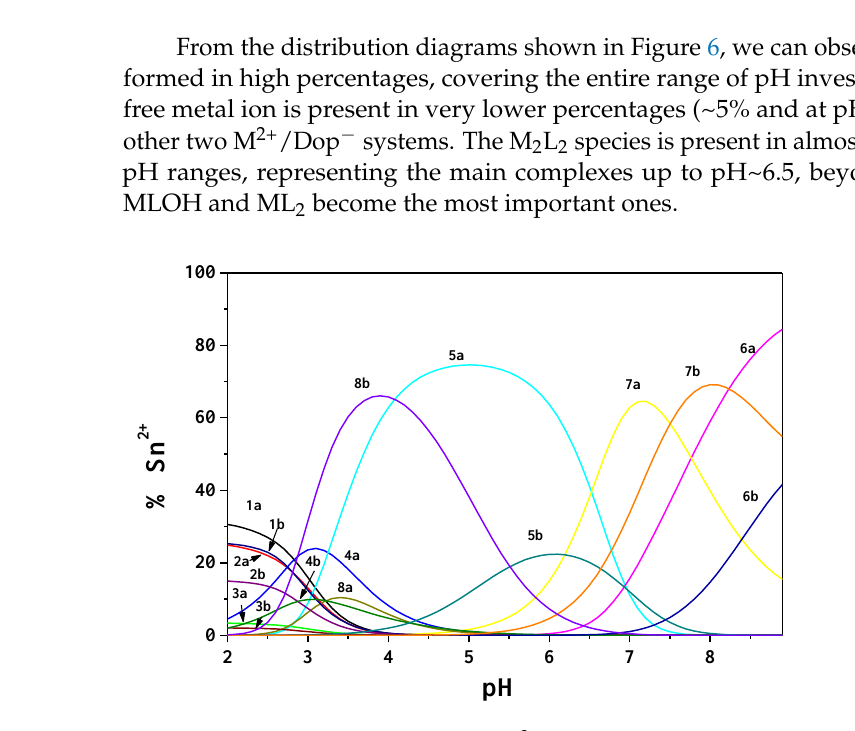
Figure 6. Distribution diagram for the Sn 2+ /Dop − species a T = 298.15 K and different ionic strengths. a: I = 0.147 mol dm −3 ; b: I = 0.954 mol dm −3 . Species: 1. MCl; 2. MCl 2 ; 3. MCl 3 ; 4. MCl(OH); 5. M 2 L 2 ; 6. ML 2 ; 7. MLOH; 8. M 2 LOH. (Experimental conditions: c Sn2+ = 1.5 mmol dm −3 ; c DOP− = 5 mmol dm −3 ) [M = Sn 2+ ; L = Dop − ].